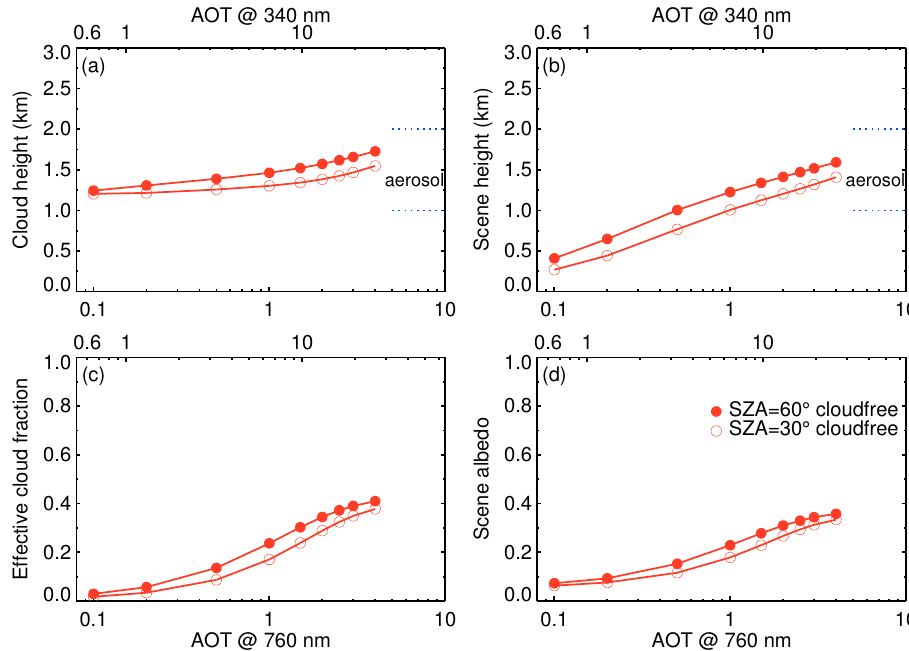
Fig. 3. Same as Fig. 2 but for the location of the BBA Case 2 aerosol layer between 1 and 2km and only cloud free scenes.